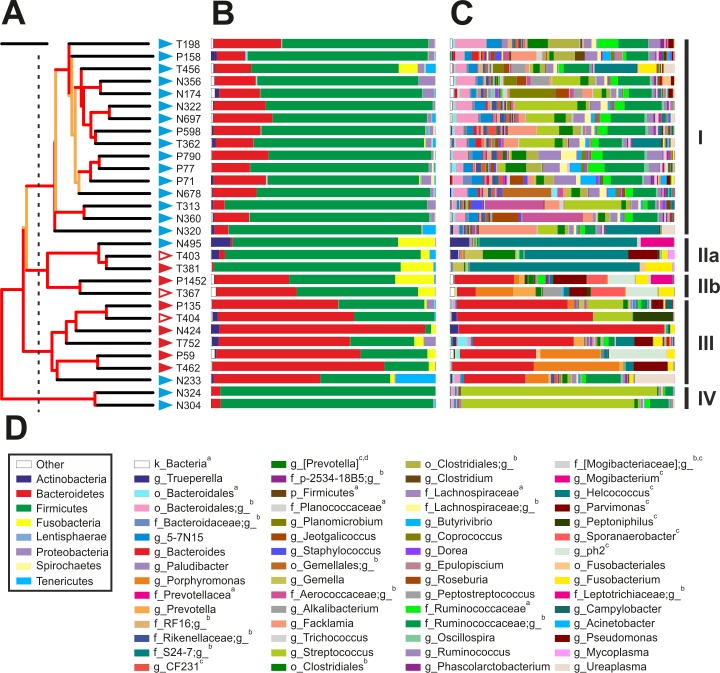
Taxonomic composition of the vaginal microbiome of cows at 7 DPP.A) Whole-microbiome weighted UniFrac hierarchical cluster. Jackknife support of internal tree nodes is colour coded. Red, 75–100%; orange, 50–75%. The identity of the samples is given to the right of the branch tips. Scale bar represents 0.1 distance. Cluster membership as defined by the branching pattern of this dendrogram is shown at the far right of the figure and is based upon a distance cut off displayed by a dashed line. B) and C) Taxonomic composition at phylum and genus levels, respectively. Each bar represents the complete microbiome as observed in each of the vaginal samples. D) Colour key of selected phyla (within box) and genera from B and C. Superscripts: a OTUs with ambiguous assignment below the indicated taxonomic level; b OTUs that although matching reference sequences in the Greengenes 13_8 database, no taxonomic name has been defined. In these cases, the lowest taxonomic name is provided; c OTUs matching reference sequences for which taxonomic changes above the rank of genus have been recommend by Greengenes based on whole genome phylogeny; d OTUs matching Genus name contested. Complete taxonomy plots derived from QIIME are shown as supporting information (S4 Fig). Healthy N = 20 (blue triangles) and Endometritis N = 10 (red triangles; borderline: open triangles). Clinical assignments were made at 21 DPP or later based on the vaginal mucus score.